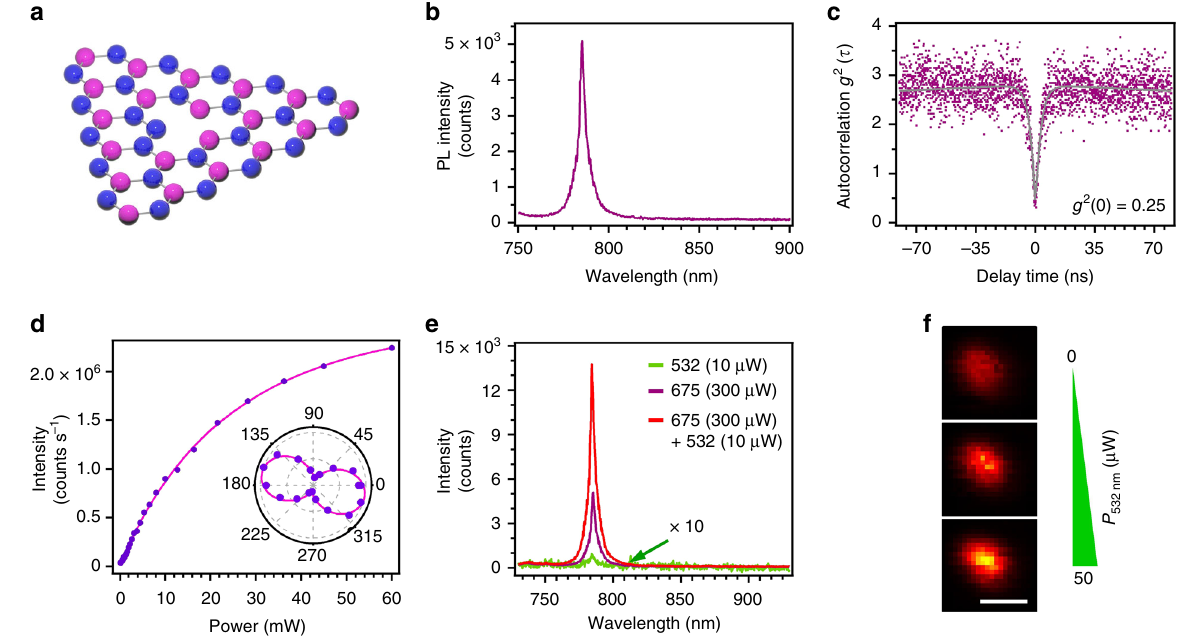
Fig. 1 Single photon emission from hBN. a Two-dimensional hBN hosting a fl uorescent defect. b Photoluminescence spectrum of the single defect in hBN under 675 nm excitation. c Second-order autocorrelation measurement g (2) ( τ ) of the defect with a dip at g (2) (0) ≈ 0.25, indicating single photon emission. d Saturation curve of the emitter under excitation with a 708 nm laser. The solid line is the fi t to I ¼ I 1 ´ P = ð P þ P sat Þ , according to which the 50% of the saturated emission occurs at 14 mW. Inset: emission polarization curve of the emitter. The emission dipole is in the plane of the layered host crystal. (Note: the 708 nm laser was used in lieu of the 675 nm one for measurements requiring high power). e Photoluminescence spectra of the single defect under three excitation conditions: low-power (10 µ W) 532 nm laser (green trace), high-power 675 nm laser (purple trace) and coincident excitation with both lasers (red trace). It is noteworthy that the spectrum under excitation with the 532 nm laser (green trace) has been multiplied tenfold for display purposes. f Nonlinear increase of the emitter brightness upon a linear increase in the power of the 532 nm excitation laser coincident with the 675 nm excitation laser. Scale bar is 500